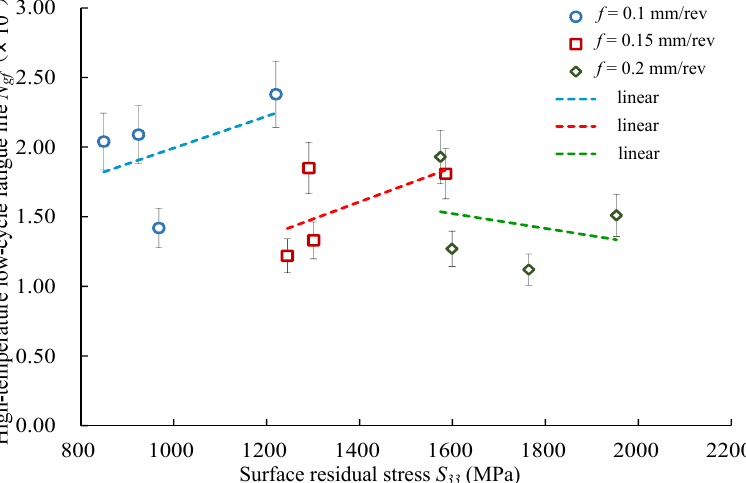
Figure 10. Effects of surface residual stress S 33 (feeding direction) on low-cycle fatigue life.